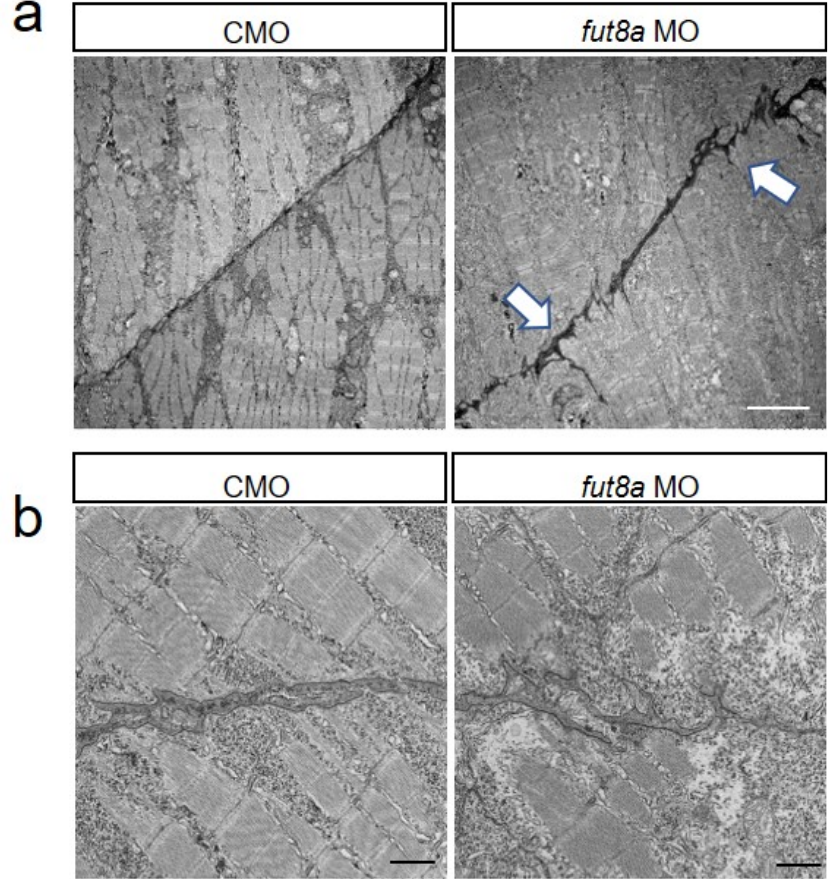
Figure 4. fut8a morphants have abnormal myosepta Representative electron micrographs of longitudinal section of morphants (2 dpf). ( a ) Electron micrograph of dorsal myosepta. White arrows indicate the tear sites in the myosepta. Scale bar: 5 μ m. ( b ) Enlarged views of electron micrograph of dorsal myosepta. Scale bar: 1 μ m. Maximum width, total length, and straightness factor of myosepta were quantified and indicated in Supplemental Figure S2.